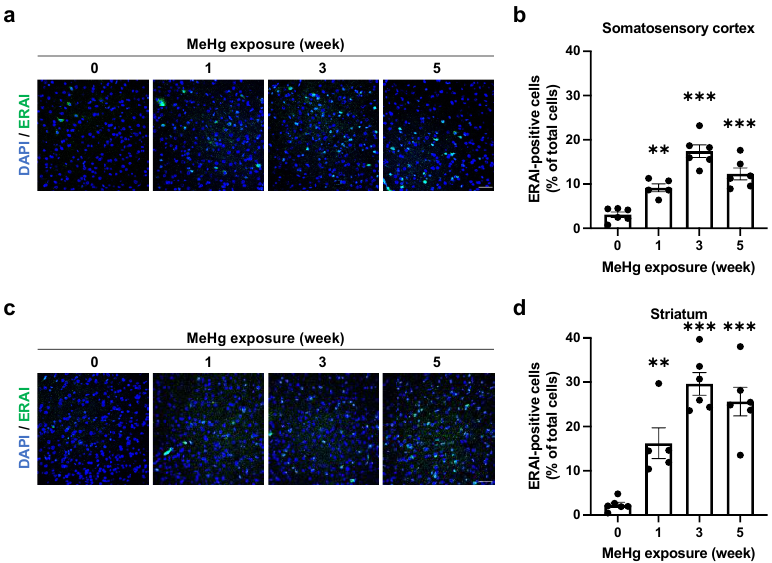
Figure 2. Time course analysis of MeHg-induced ER stress using ERAI-Venus mice. ERAI-Venus mice were exposed to 50 ppm MeHg via drinking water. At the indicated times, the mice were sacrificed, and the brain tissues were analyzed by immunostaining. ( a , c ) ERAI fluorescence signal in the somatosensory cortex and striatum of ERAI-Venus mice exposed to MeHg for the indicated time. The scale bar represents 50 μm. ( b , d ) Quantification of ERAI-positive cells shown in ( a , c ). Data are expressed as the mean ± S.E.M. values (n = 5 – 6, ** p < 0.01, and *** p < 0.001: significant difference compared with control mice without MeHg exposure (0 weeks) by one-way ANOVA with Dunnett’s post hoc test). 2.3. The UPR Signals Are Altered by MeHg Exposure in the Mouse Brain Upon sensing ER stress, IRE1α is activated via autophosphorylation and induces the expression of molecular chaperones and ERAD-related proteins by splicing XBP1, thereby relieving ER stress [24,25]. We have previously shown that 30 ppm MeHg exposure transiently upregulates the expression of HRD1, a downstream factor of the IRE1α -XBP1 axis, similar to the ERAI signaling pattern [22]. Therefore, we examined the changes in IRE1α activity and downstream HRD1 expression by 50 ppm MeHg exposure. In the somatosensory cortex (Figure 3a – c) and striatum (Figure 3d – f), there was a trend toward a time-dependent increase in the number of phosphorylated IRE1α (p - IRE1α) -positive cells upon MeHg exposure, but the increase in HRD1-positive cells was only transient. Previously, we confirmed that XBP1 mRNA splicing is reduced and apoptosis is promoted via S- mercuration of IRE1α in vitro [16]. Since XBP1 is inv olved as a transcription factor in inducing the expression of HRD1, a downstream factor in the IRE1α pathway, it is possible that IRE1α function may be altered by S -mercuration in the mouse brain.